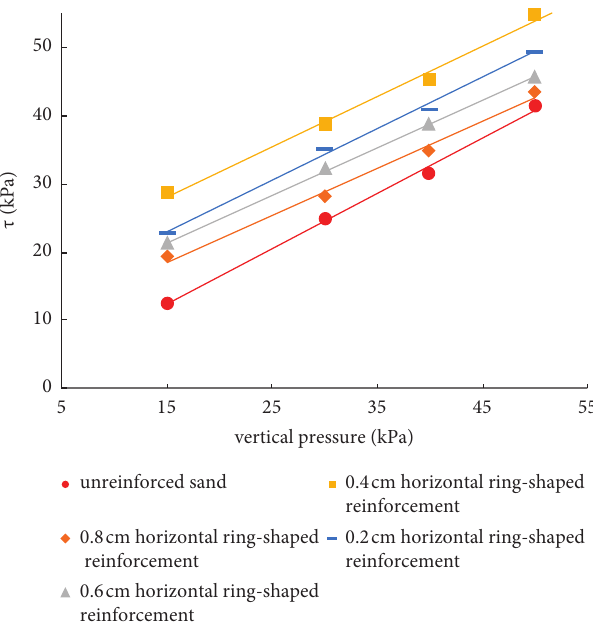
Figure 17: Shear strength curve of annular kraft paper-reinforced sand with different widths. Table 2: Comparison of shear strength indexes.